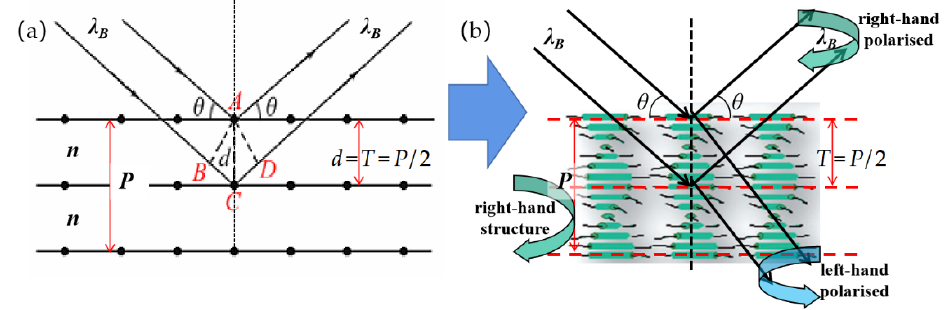
Figure 2. Schematic drawing of Bragg diffraction in ( a ) crystalline and ( b ) twisting LC.